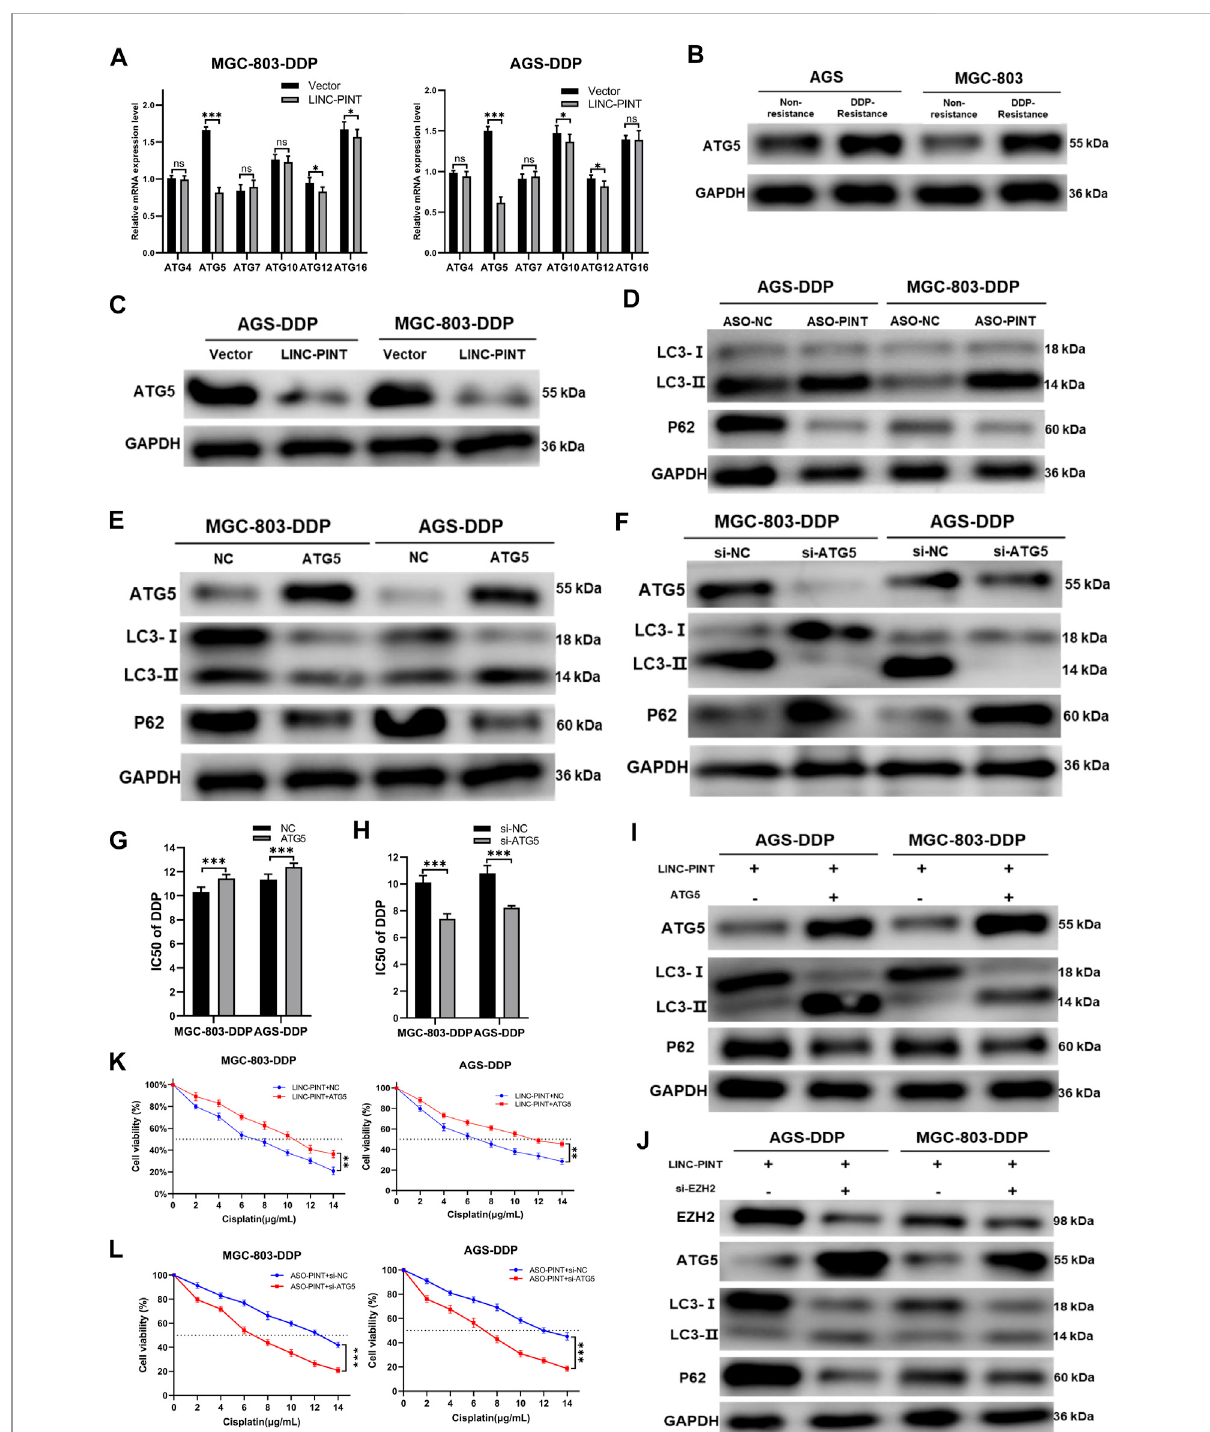
FIGURE 5 ATG5 isatarget ofLINC-PINT. (A) qRT-PCRanalysisATGsexpressioninMGC-803-DDPandAGS-DDP cells withLINC-PINToverexpression or not. (B) WesternblottingforATG5expressioninDDP-resistantGC cells. (C) WesternblottingforATG5expressioninLINC-PINToverexpressedAGS- DDP cells and MGC-803-DDP cells. (D) Western blotting for ATG5 expression in LINC-PINT silenced AGS-DDP cells and MGC-803-DDP cells. (E) Western blotting for ATG5, LC3 and p62 in ATG5 overexpressed MGC-803-DDP and AGS-DDP cells. (F) Western blotting for ATG5, LC3 and p62 in ATG5 silencedMGC-803-DDP and AGS-DDP cells. (G) CCK-8 assay for ATG5 overexpressedMGC-803-DDP and AGS-DDP cells to evaluate the IC50 of DDP. (H) CCK-8 assay for ATG5 silenced MGC-803-DDP and AGS-DDP cells to evaluate the IC50 of DDP. (I) Western blotting for ATG5,